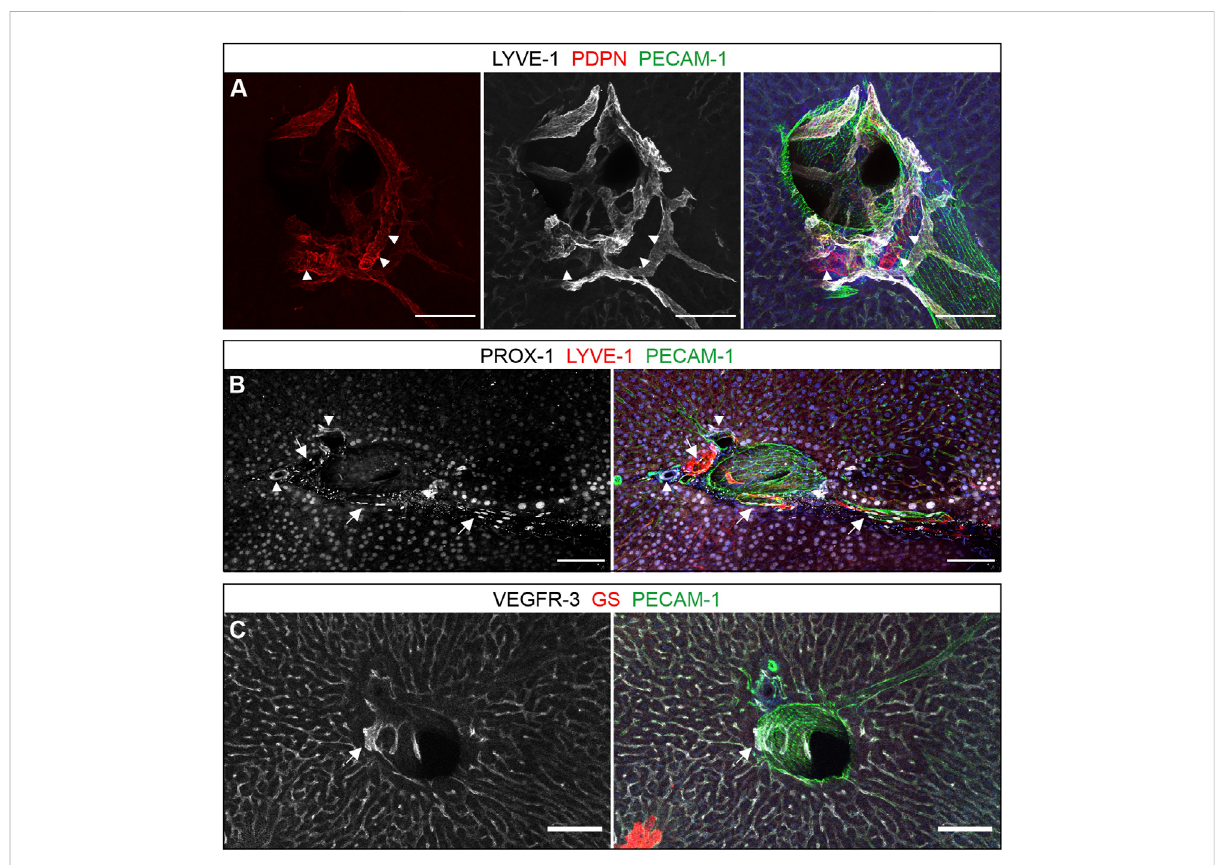
FIGURE 1 Lymphatic surface markers in the liver. ( A – C) : Vibratome sections (300 µm) immunostained for the proteins indicated above the panels are shown as maximum intensity projections. (A) : PDPN and LYVE-1 co-localized on lymphatic vessels, while exclusive PDPN expression was restricted to bile ducts (arrowheads). (B) : Prox1 was detected on LYVE-1-positive lymphatics (arrows), bile ducts (arrowheads) and surrounding hepatocytes. (C) :VEGFR-3wasexpressedonsinusoidsaswellaslymphaticvessels(arrow),herenexttoaportalvenousbranchasindicatedbytheabsenceof GS staining on neighboring hepatocytes. (A – C) : Scale bars = 100 µm, nuclear counterstaining with